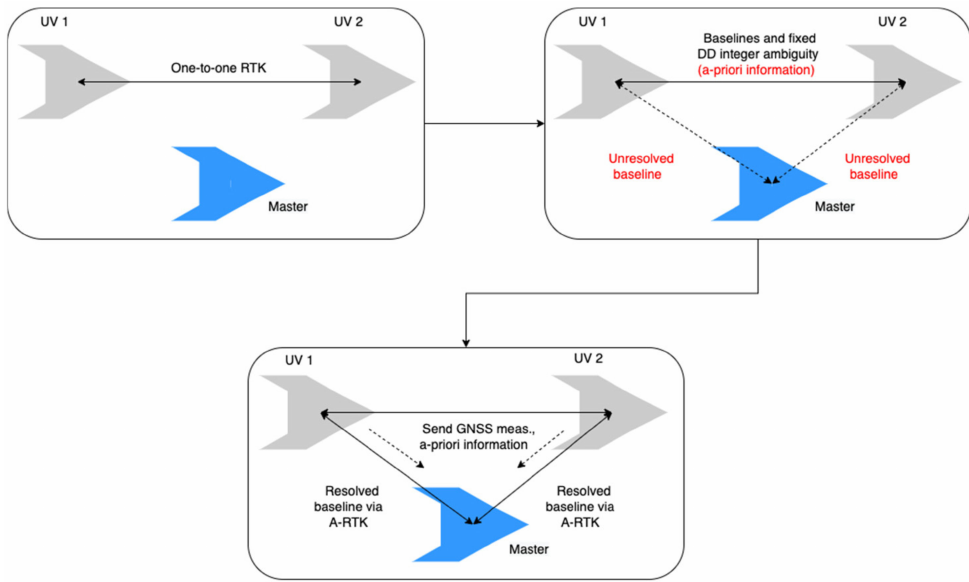
Figure 1. RTK positioning procedures in a cell consisting of two follower UVs and a master UV. Two UVs perform the one-to-one RTK first, and the estimated baselines and resolved integer ambiguities are sent to a master that implements antenna array-aided RTK (A-RTK).